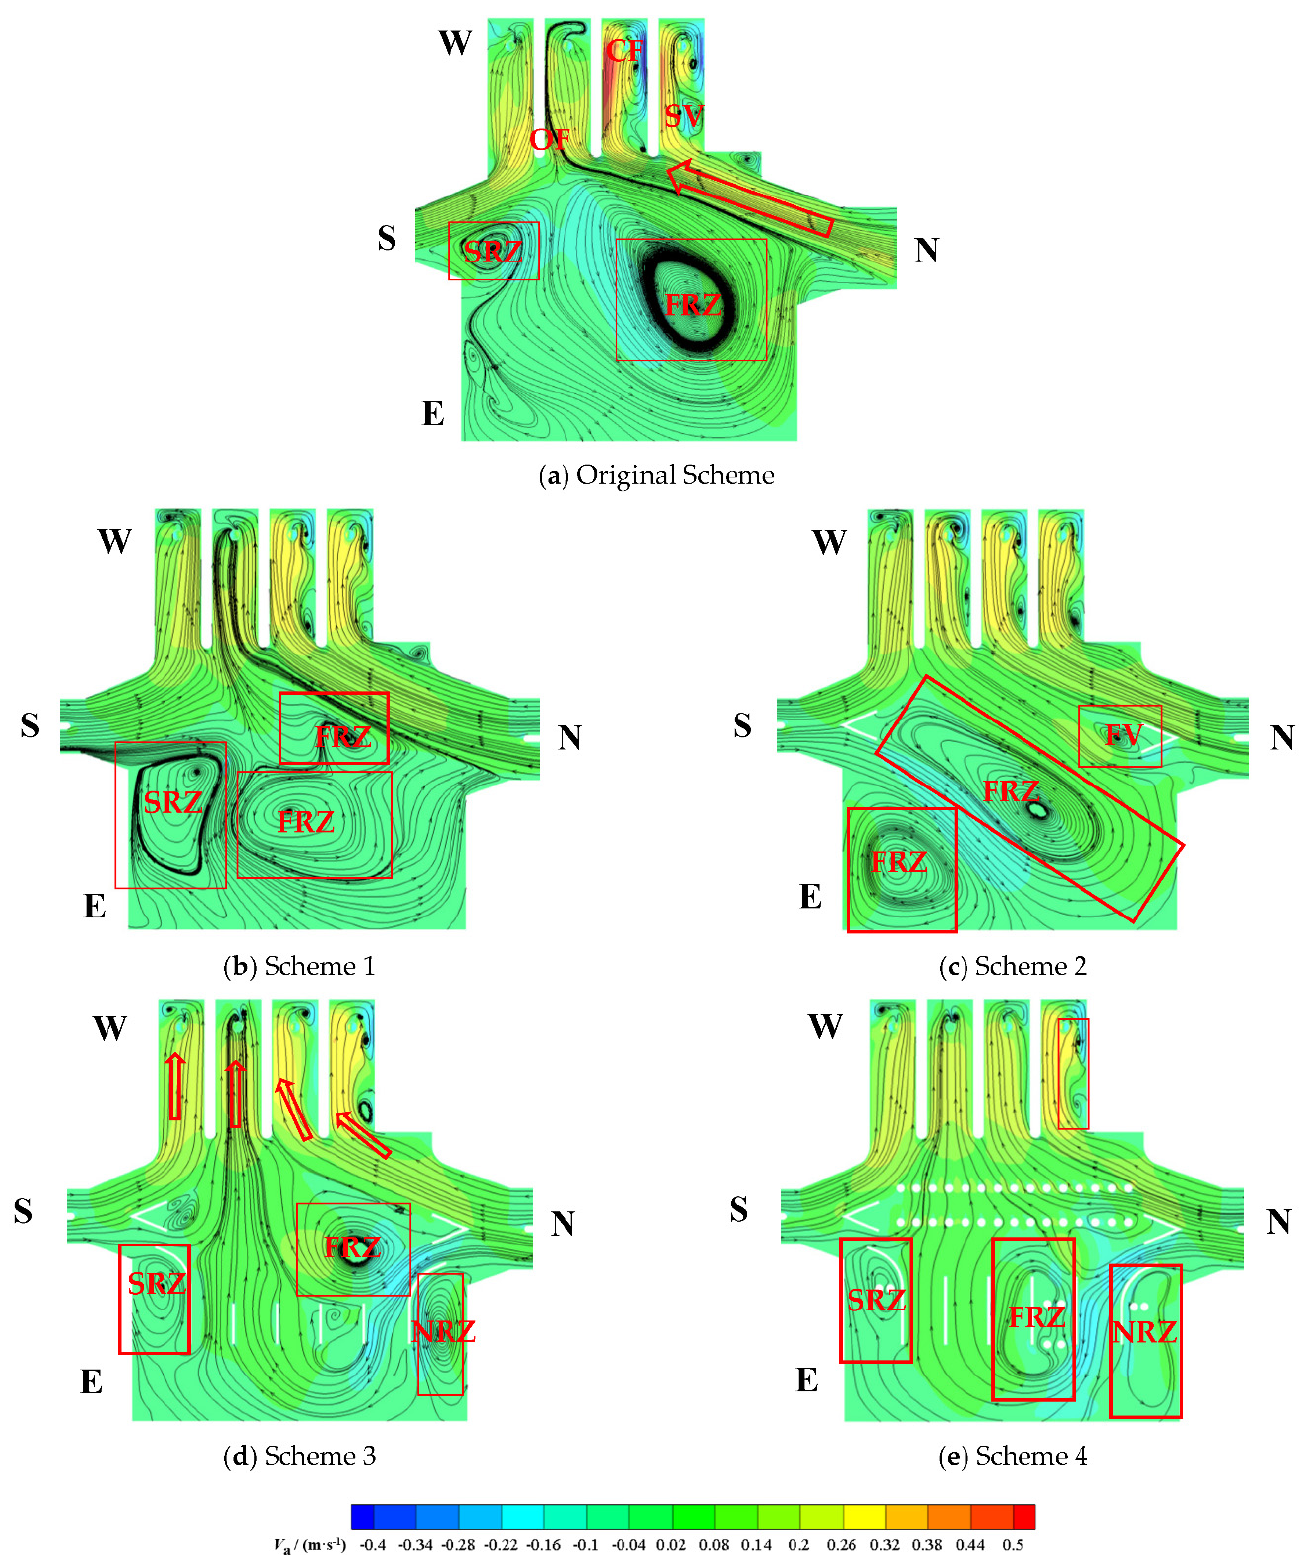
Figure 8. Middle streamline and axial velocity contour chart.